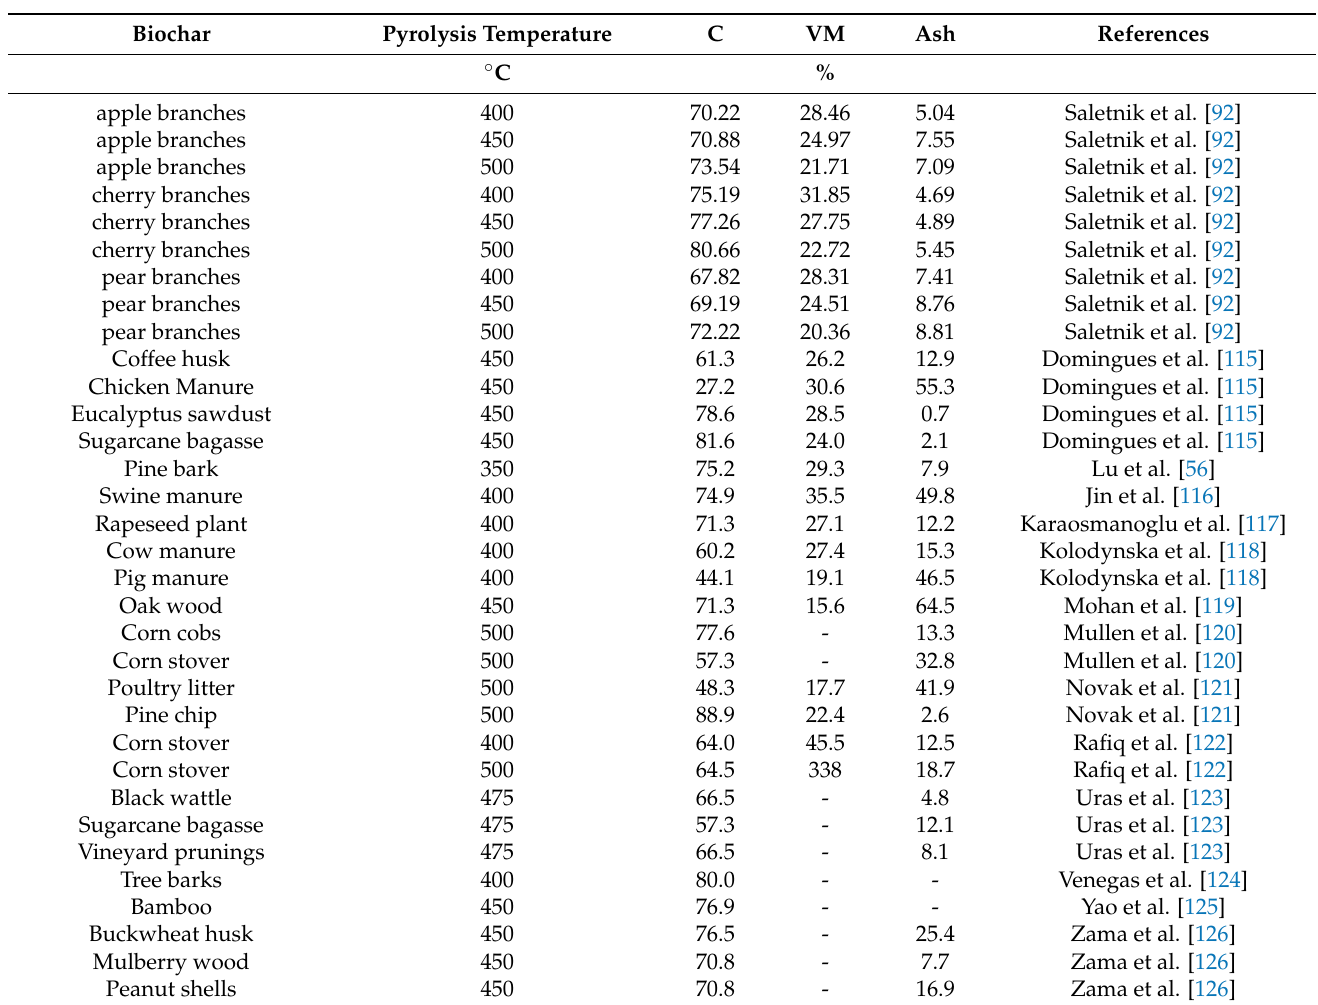
Table 4. Biochar characteristics in different temperatures from